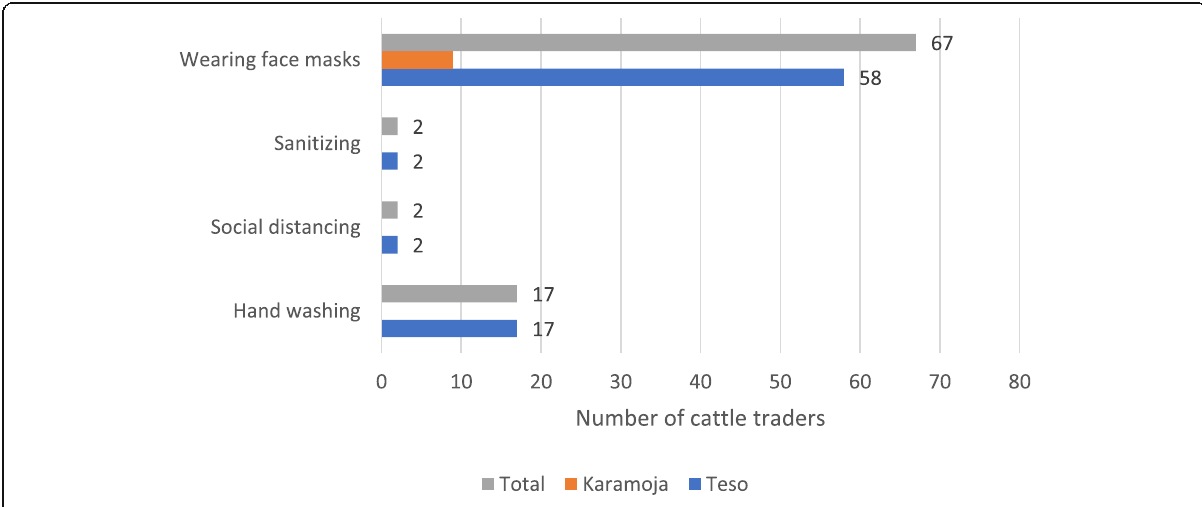
Fig. 10 Number of cattle traders practising the COVID-19 SOPs after lockdown. Source: primary data